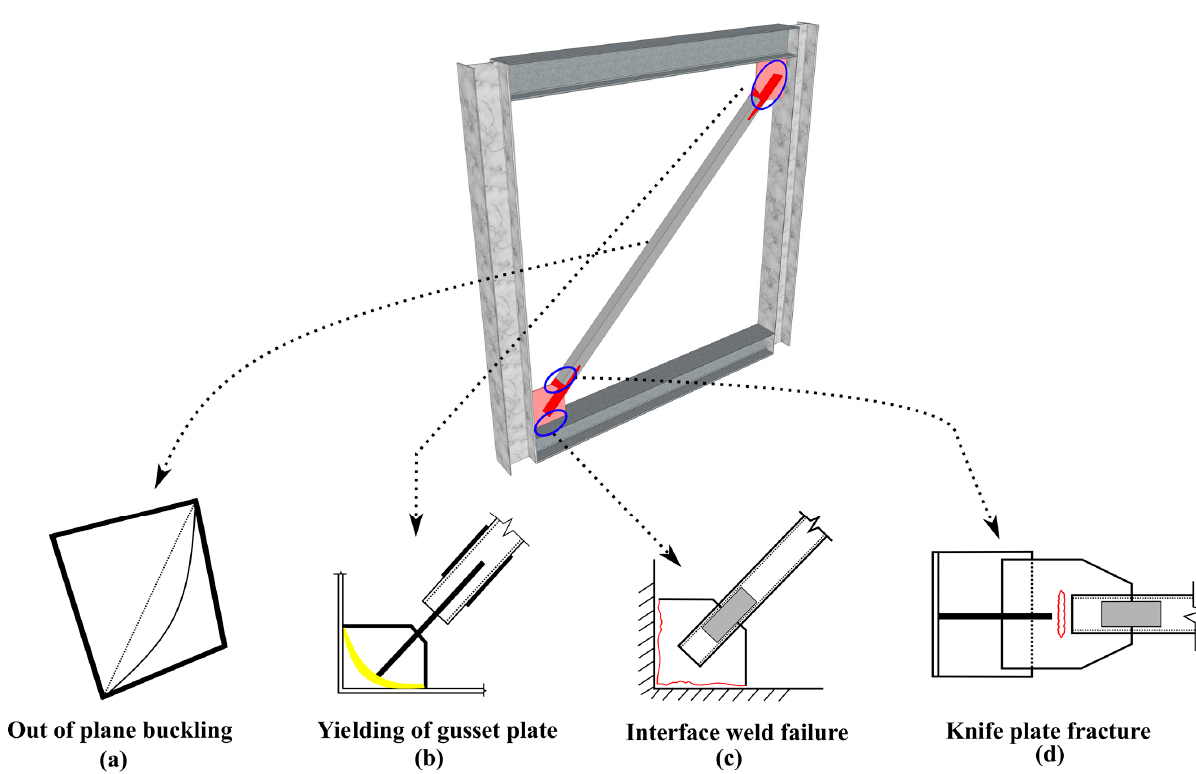
Figure 4. Failure modes observed in past experimental studies [10,31,32].